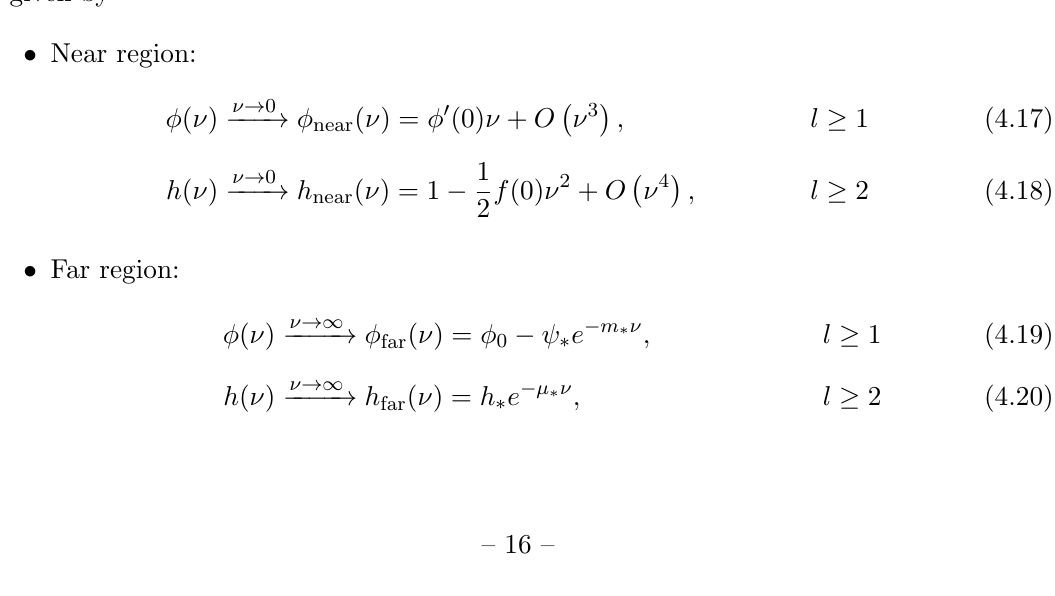
as (cid:23) are represented by the ! 1 ? divergence is linear, and the open circles where it is ? 1 and l 1. (cid:21) (cid:21) l (cid:0)